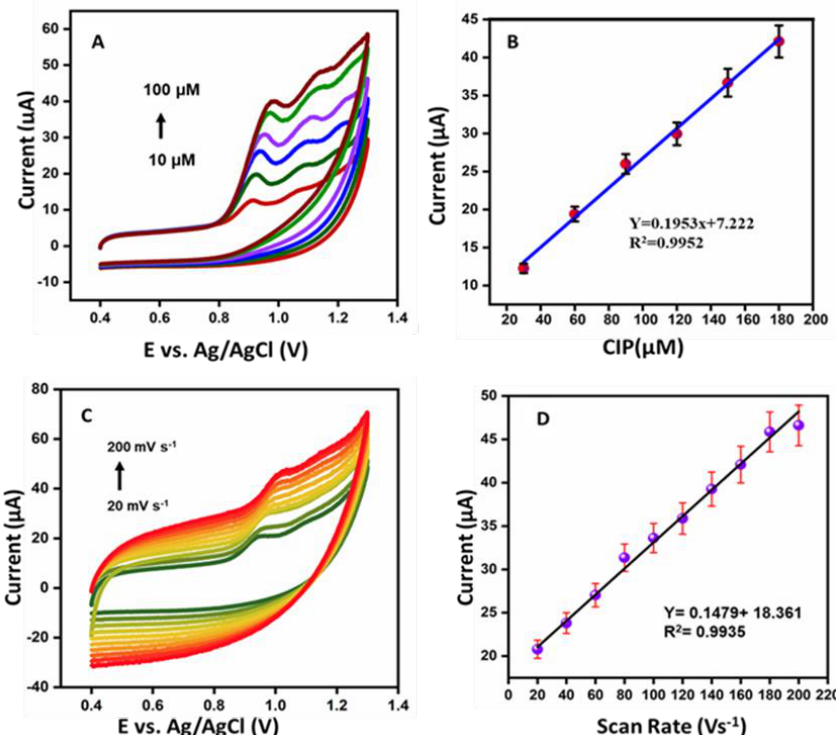
Figure 7. ( A ) CV curve of GCE/ZnWO 4 /CB with various additions of CIP (0–100 µ M) at 50 mVs − 1 ; ( B ) linear plots of current ( I pa ) vs. other concentrations of CIP; ( C ) CV curves of the altered electrode GCE/ZnWO 4 /CB towards 100 µ M CIP at various sweep rates (20–200 mV s –1 ); and ( D ) The graph between the square root of scan rate (v 1/2 ) and anodic peak current was done with N 2 immersed pH 7.0 (0.05 M PBS).